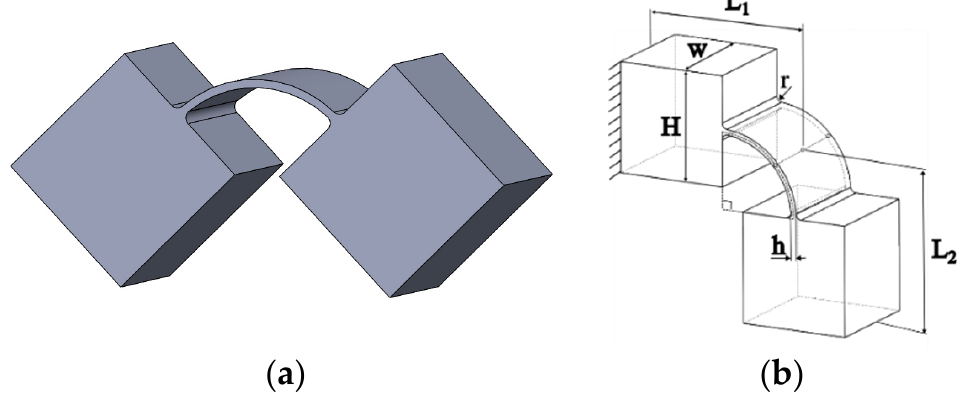
Figure 3. Curved flexure hinge: ( a ) Model and ( b ) Geometrical representations